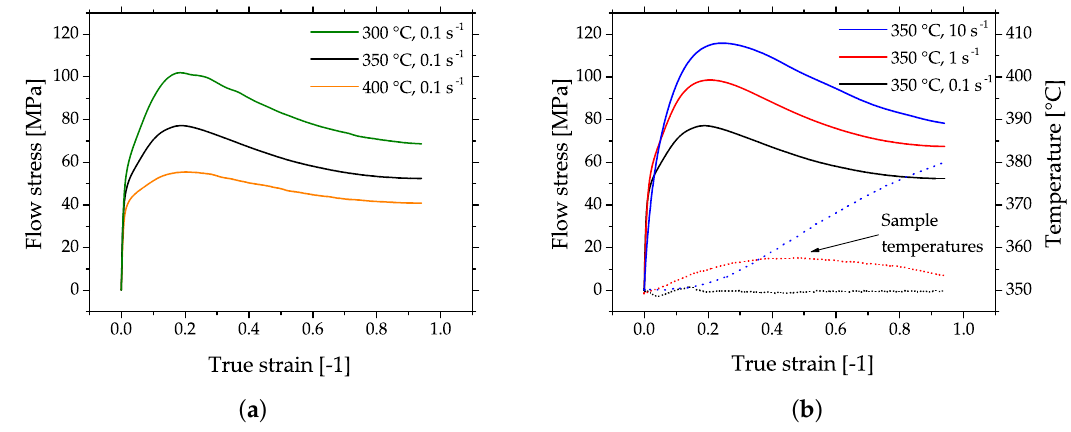
Figure 3. Flow curves of cast and homogenized AZ31, obtained by cylinder compression testing. The plots show the flow stress (full lines) of samples tested with( a ) varying temperatures and( b ) varying strain rates. The dotted lines in(b) show the increasing sample temperatures with increasing strain rate. No temperature compensation was done for the shown flow stress